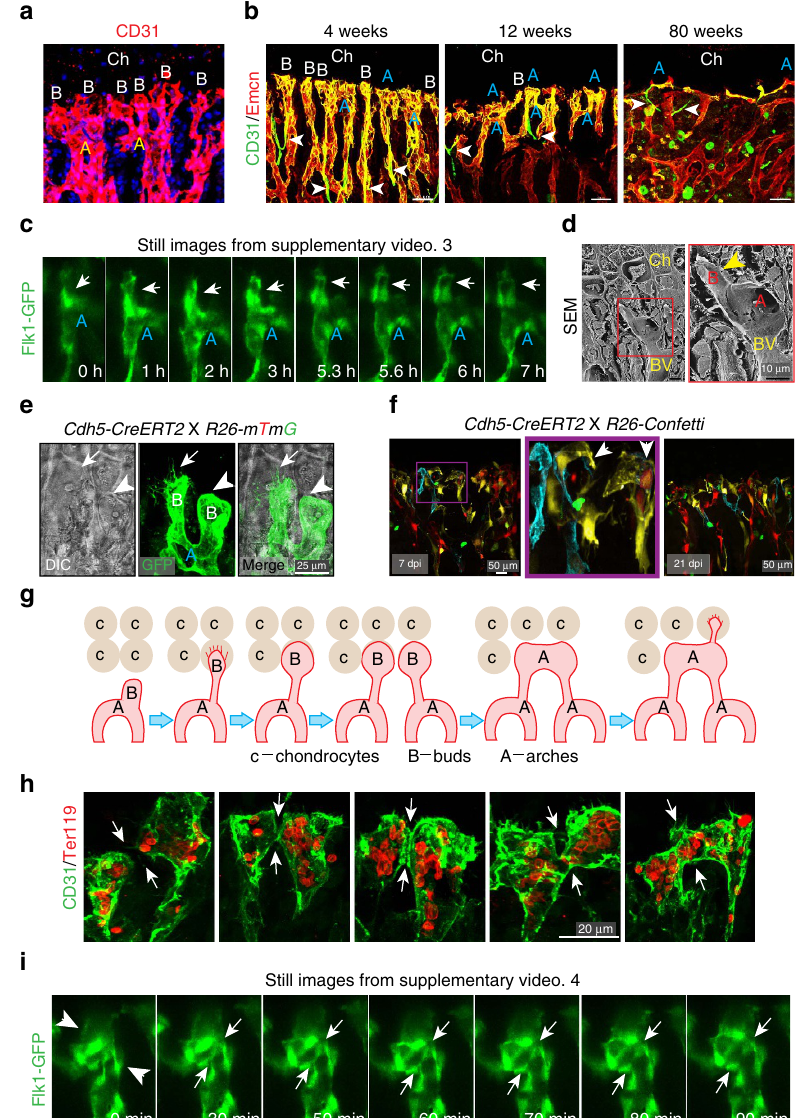
Figure 3 | Blood vessel growth in bone. ( a ) Maximum intensity projection of metaphyseal vessel structures (CD31, red): distal, loop-like arches (A) and bud-shaped protrusions (B) present in proximity of hypertrophic chondrocytes (Ch). ( b ) Representative confocal images of tibia sections from 4, 12 and 80-week-old mice immunostained for Emcn (red) and CD31 (green). CD31 hi Emcn hi ECs form columns, distal arches (A) and buds (B) at the vascular growth front, which were abundant at 4 weeks but declined during ageing (12 and 80 weeks). Arrowheads indicate Emcn- arterioles. Ch, chondrocytes. ( c ) Still images of the indicated time points from a 10h time lapse movie of 10-day-old Flk1-GFP metatarsal. Arrow indicates bud emerging from arch (A). ( d ) SEM images of blood vessel (BV) next to chondrocytes (Ch) in 4-week-old tibia with distal arch (A) and bud (B; arrowhead). Right panel shows higher magnification of inset with bud emerging from arch. ( e ) Merged confocal and differential interference contrast (DIC) image showing distal vessel buds (B) genetically labelled by GFP (green). Arrow indicates a filopodia-bearing endothelial bud displacing an apoptotic chondrocyte, arrowhead points at filopodia- free bud next to intact chondrocyte. ( f ) 4-week-old Cdh5-CreERT2 R26-Confetti double transgenics at 7 and 21 days post injection (dpi) showing high degree of mosaicism in endothelial columns, arches and buds. ( g ) Schematic illustration of vessel growth in long bone. Invading vessels buds (B) displace apoptotic growth plate chondrocytes (c) and, through anastomosis, generate new arches (A), from which new buds can emerge. ( h ) Representative confocal images showing contact formation and anastomosis (arrows) of CD31 þ (green) vessel buds in 4-week-old tibia. Note red presence of Ter-119 þ RBCs (red) in buds and forming vessel arches. ( i ) Still images (time indicated) from movie showing anastomosis (arrows) of 2 buds (arrowheads in left image) in 10-day-old Flk1-GFP (green) metatarsal. Arrows show the disappearance of junction between anastomosing buds at later time